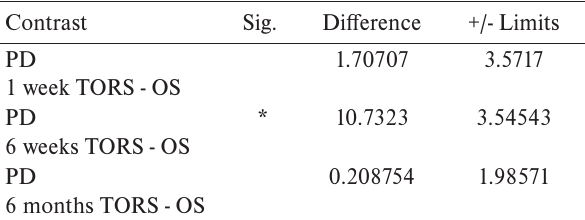
Table 4. pd - statistical difference between tested groups. contrast sig.